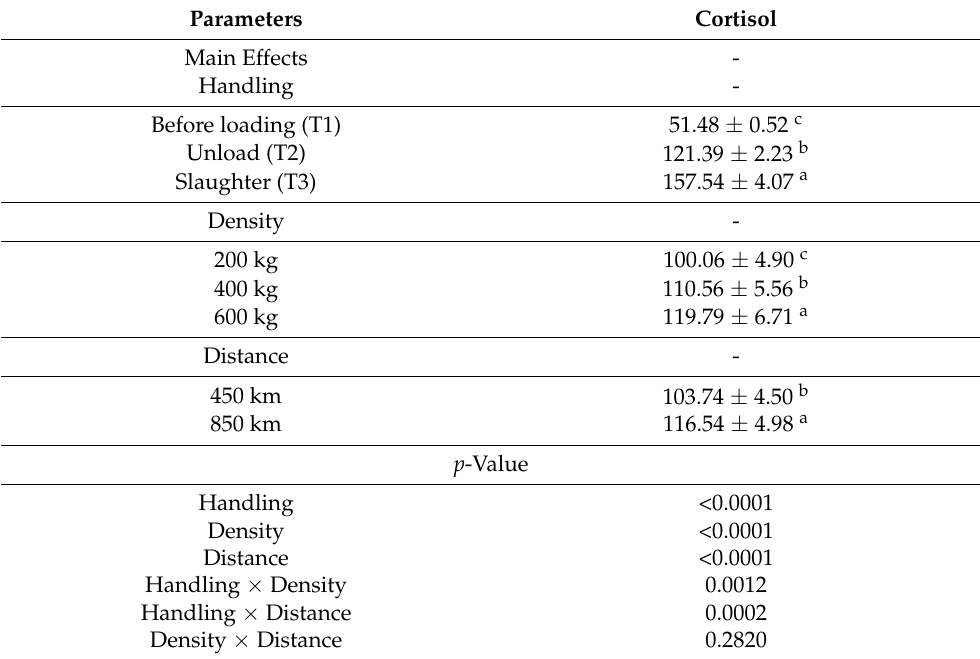
Table 4. Cortisol, as influenced by handling, stocking density and distances in Brahman crossbred cattle.